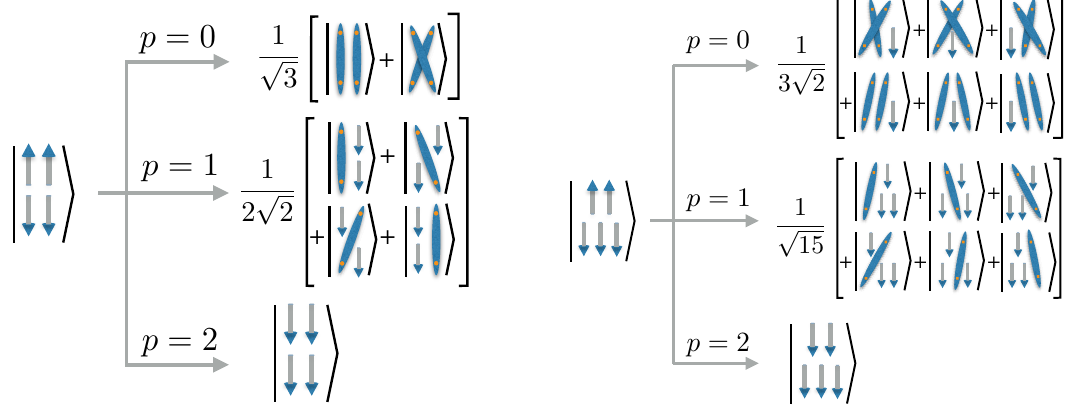
Figure 2: RVB state after emission of p photons. The sum over P permutations of the M spins in the top row, with M ! permutations. The sum over P notes a sum over all N ! permutations of the N spins in the bottom row. There is an overall normalisation constant δ . M , N , p